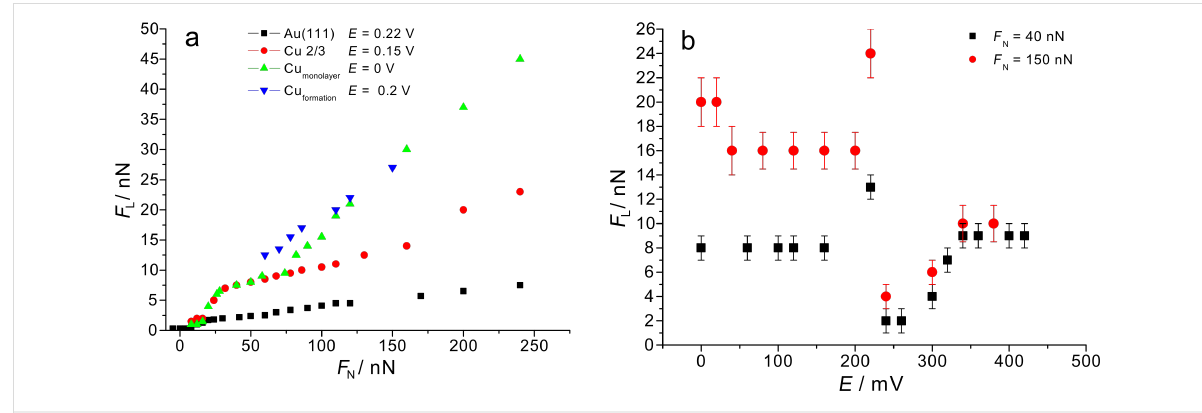
Figure 3: a) Friction force as a function of normal load. Green triangles: E = 0 V (Cu monolayer); red circles: E = 0.15 V (2/3 Cu coverage); black squares: E = 0.22 V (Au pzc). b) Friction force as a function of potential. Black: F N = 40 nN; red: F N = 150 nN.